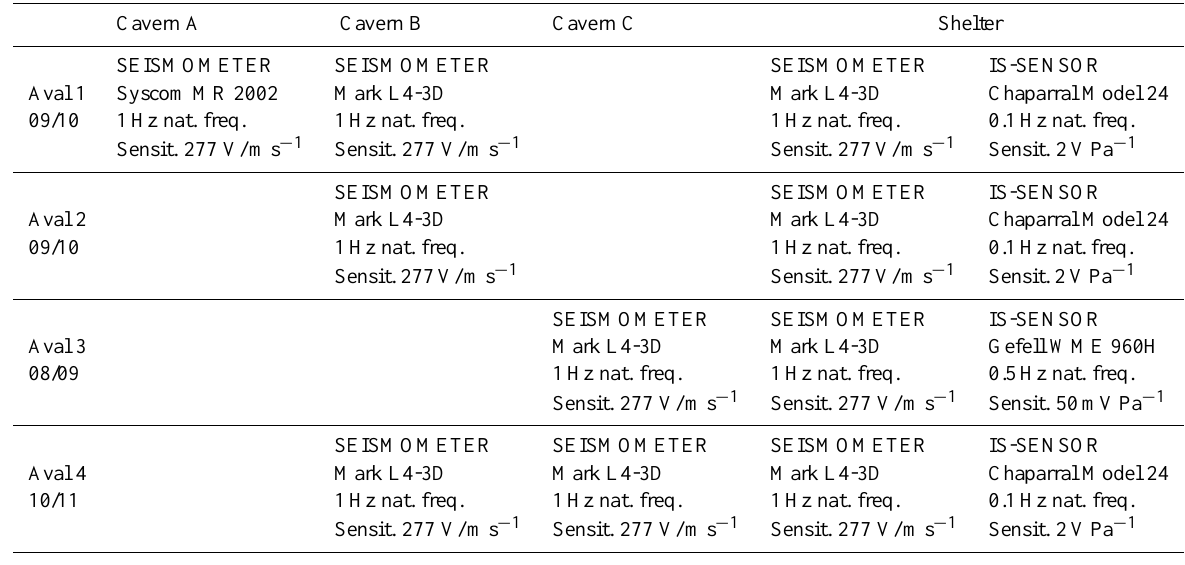
Table 1. Overview of the setup of the seismometers and infrasound (IS) sensors used in this study. The position of caverns and shelter is shown in Fig. 2.